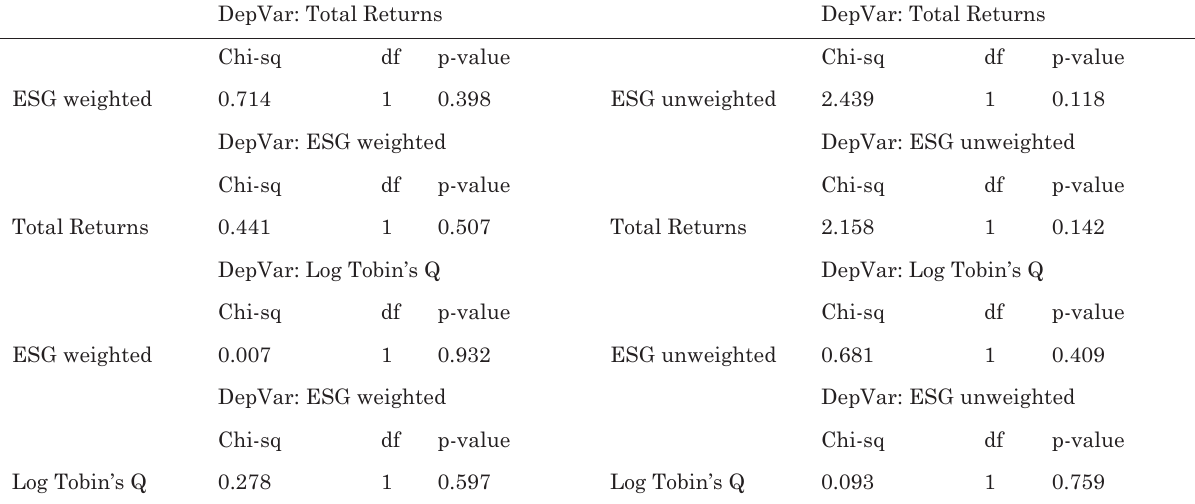
Table 4. Granger causality tests